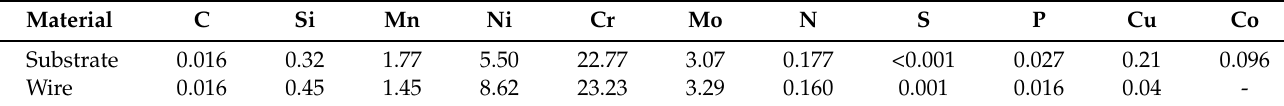
Table 3. Chemical composition (wt%) [35].